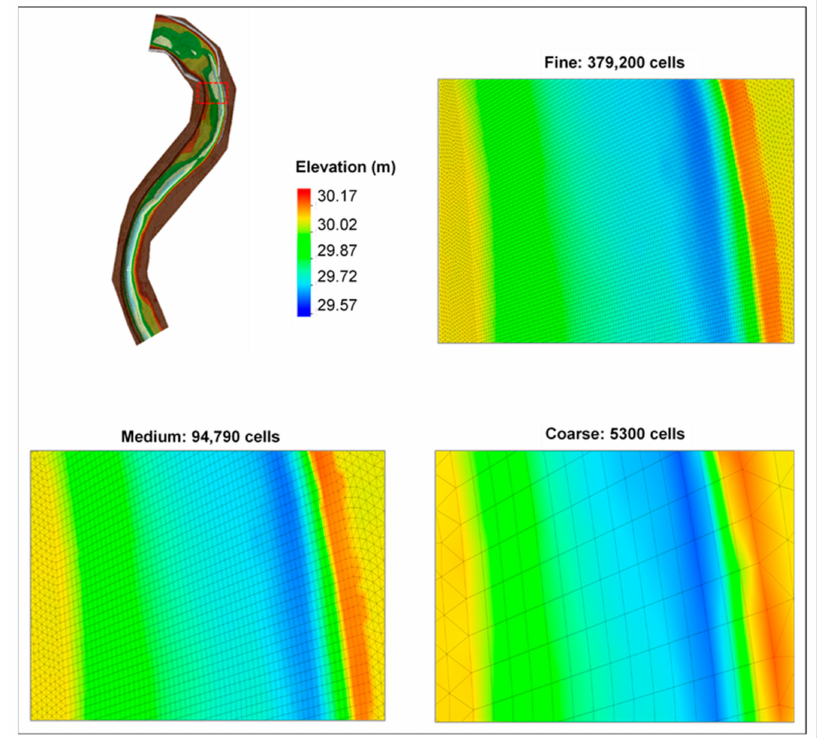
Figure 10. Bed-elevation contours for fine, medium and coarse grid sizes zoomed in on the upstream bend.